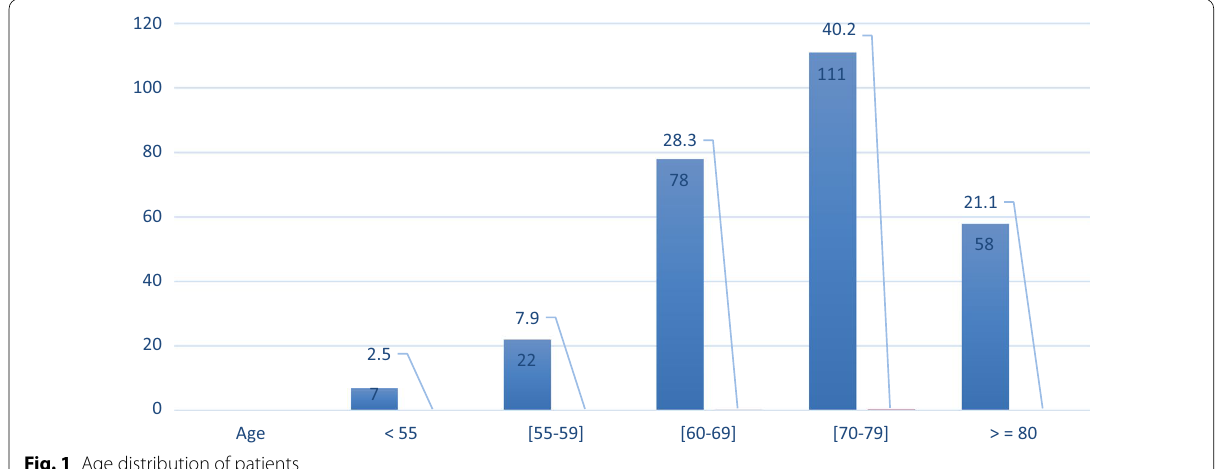
Fig. 1 Age distribution of patients